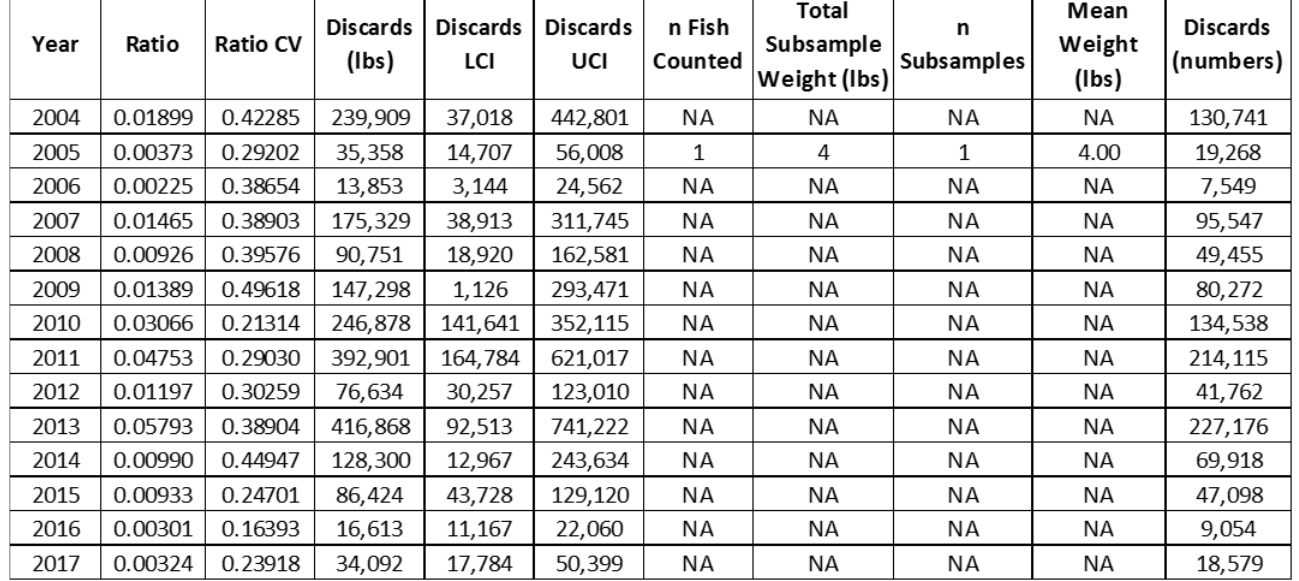
Table 31. Estimated horseshoe crab gill net discards in weight (lbs) and numbers. Data collected in 2005 was used to convert weight to discards in numbers for all years.